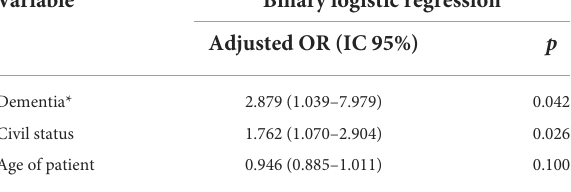
TABLE 4 Logistic regression model for therapeutic adherence on patient